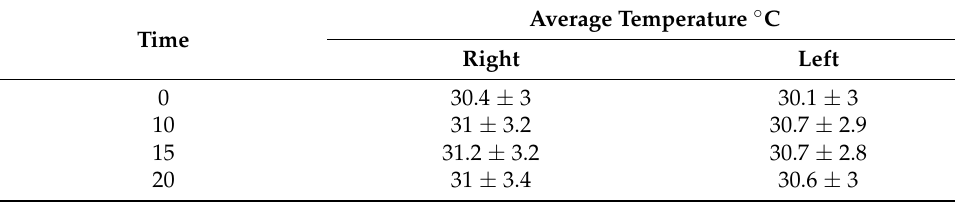
Table 3. The average temperature on the wrists of the total